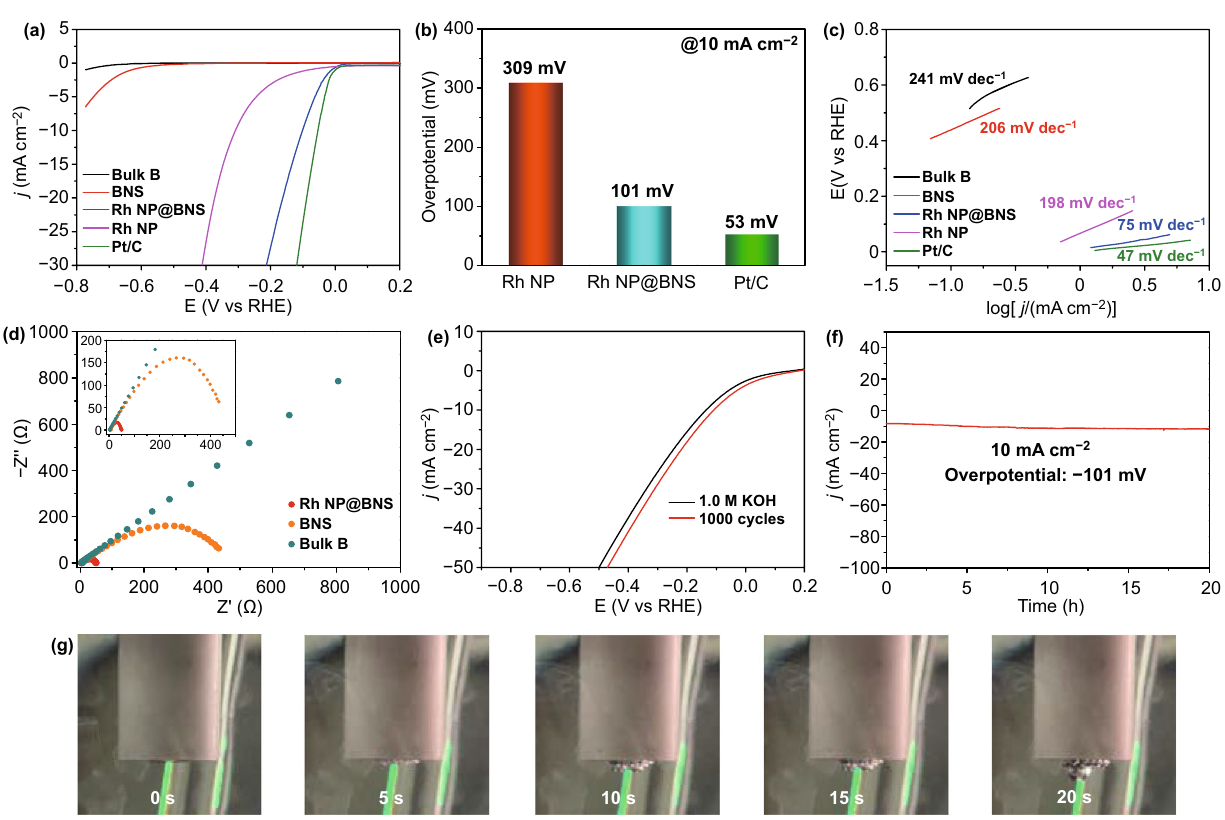
Fig. 4 a LSV curves of bulk B, BNS, Rh NP@BNS, Rh NP, and Pt/C performed in 1.0 M KOH electrolyte. b Comparison of the overpotentials at 10 mA cm −2 . c The corresponding Tafel slopes were derived from LSV curves. d Nyquist plots of bulk B, BNS, and Rh NP@BNS. e LSV curves were measured before and after 1000 cycles at 0.2 to – 0.9 V versus RHE in 1.0 M KOH electrolyte. f Time dependence of current den- sity at 66 mV versus RHE. g Photos of a working electrode using Rh NP@BNS as a catalyst during CV measurement from 0 to − 0.2 V in 1.0 M KOH electrolyte. The photos were taken at 5 s